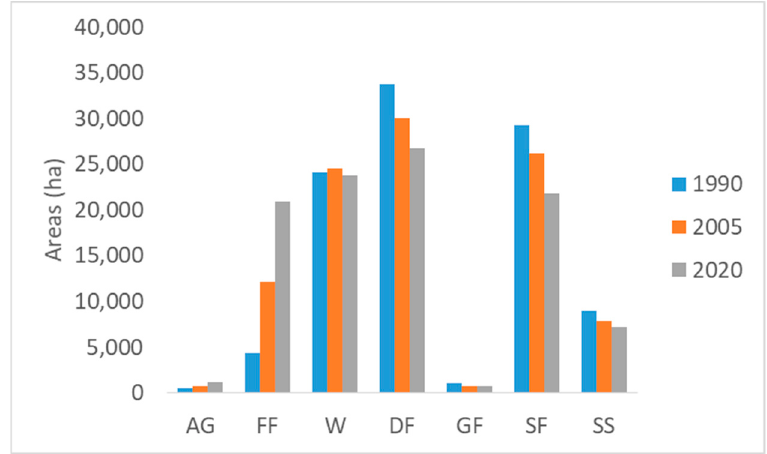
Figure 3. Variation in areas of land cover classes in the Ouémé Delta between 1990 and 2020. AG: Agglomeration; FF: Fields and fallows; W: Water; DF: Dense forest; GF: Gallery forest; SF: Swamp forest; SS: Shrubby tree savannah.